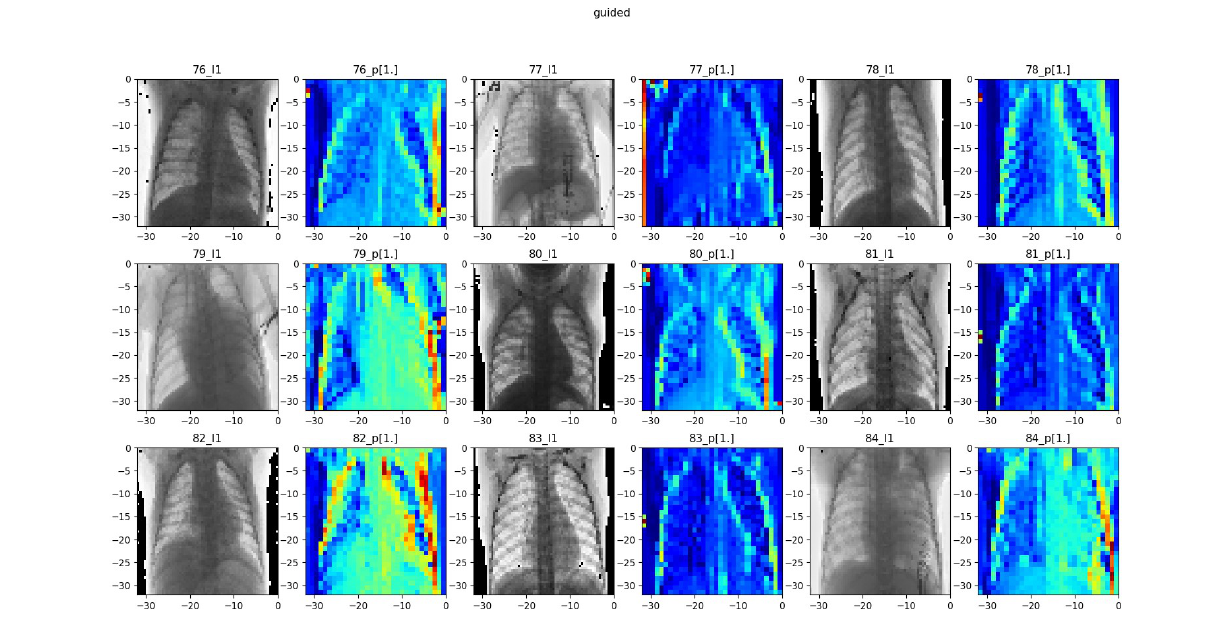
Figure 5. Visualizations of X-ray images and the generated abnormalities regions images on pneumoconiosis patients